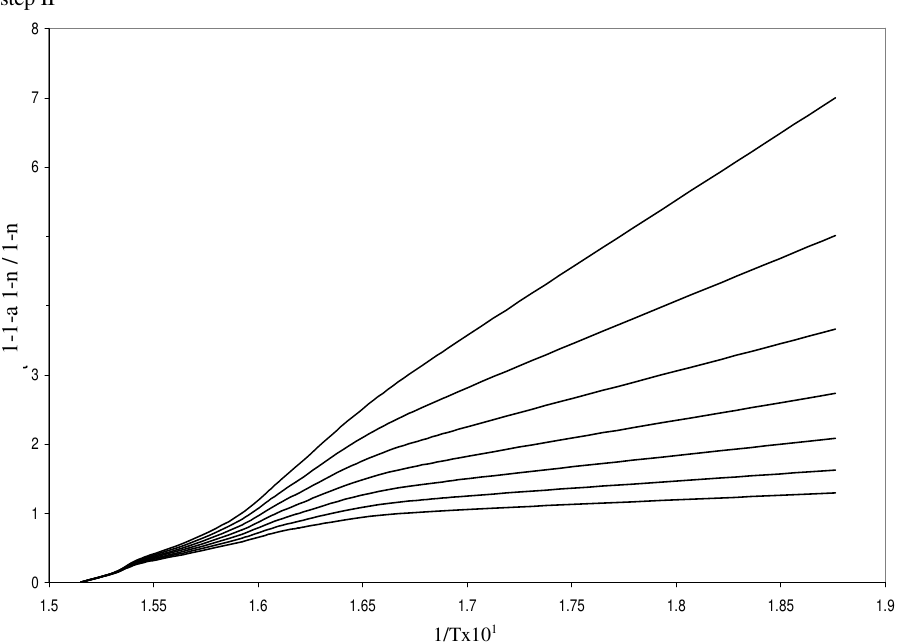
Figure 7. Plot between – log step II